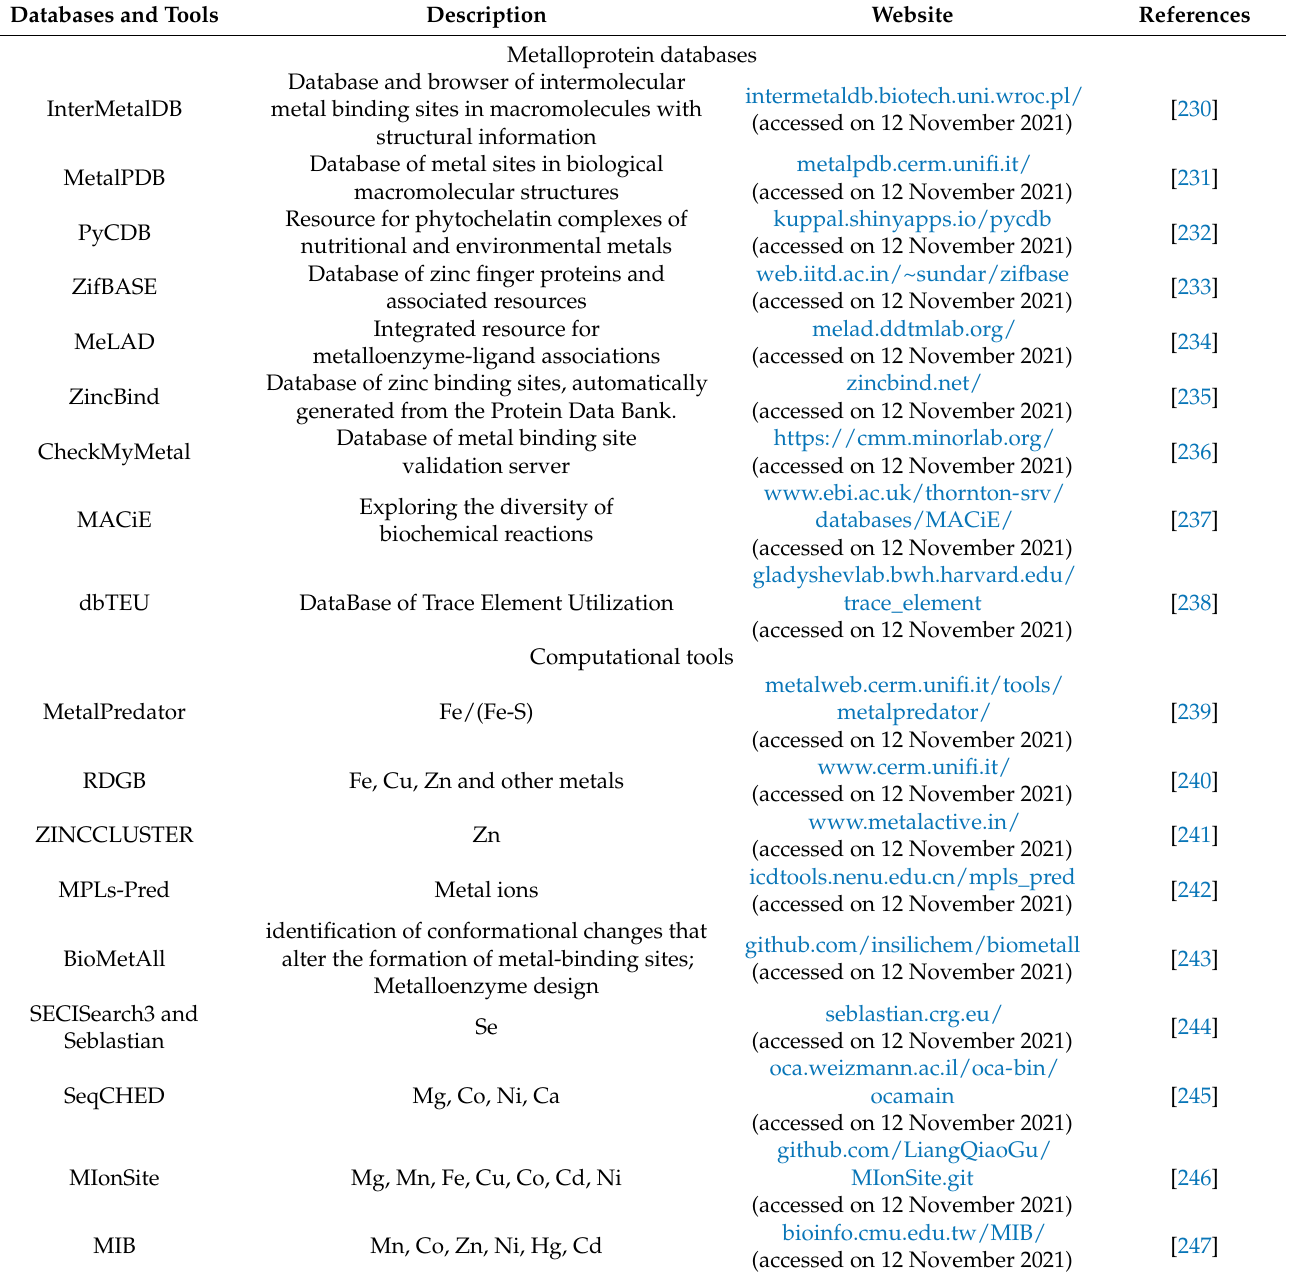
Table 2. The metalloprotein databases and tools for calculating metal binding